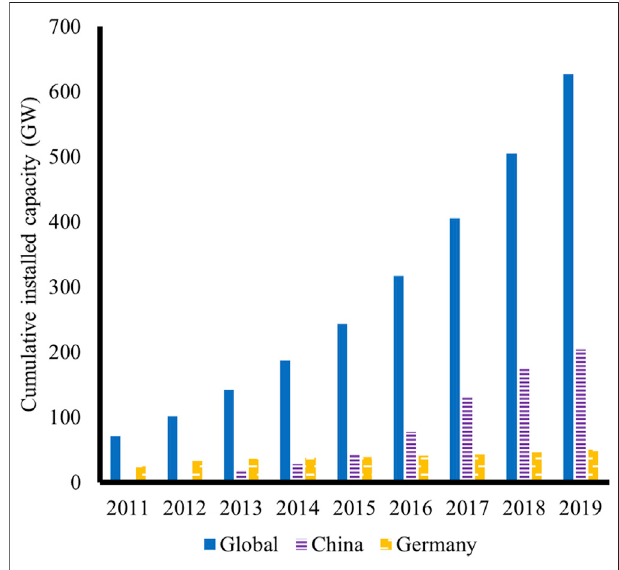
FIGURE 1 | Cumulative installed capacity of PV in the world, China and Germany from 2011 to